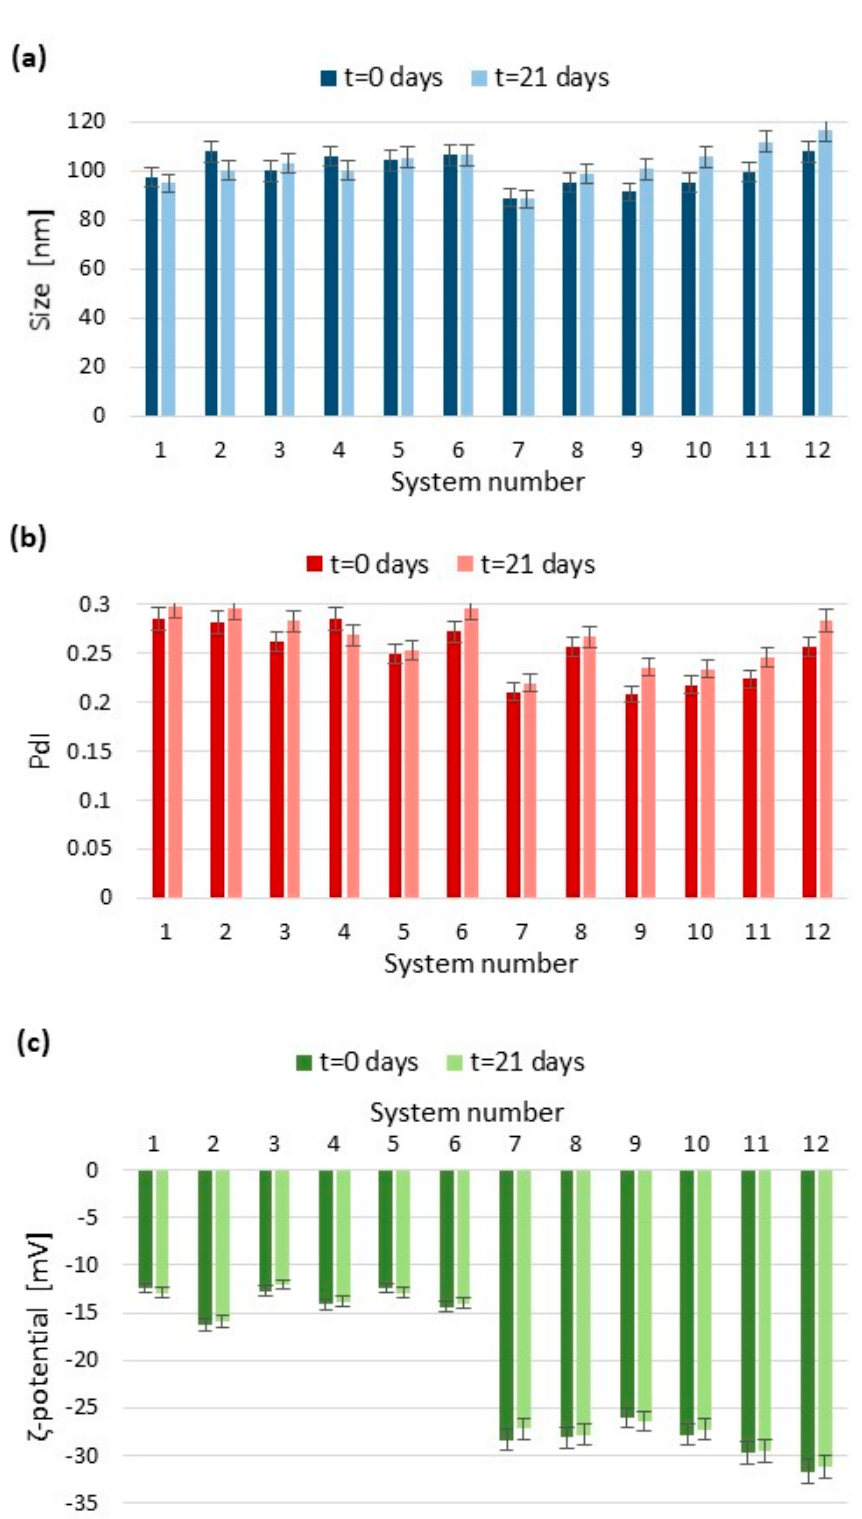
Figure 1. Influence of the process parameters on ( a ) size and ( b ) polydispersity index ( c ) ζ -potential of the studied lipid nanoparticles. Details of the system number are included in Table 1.